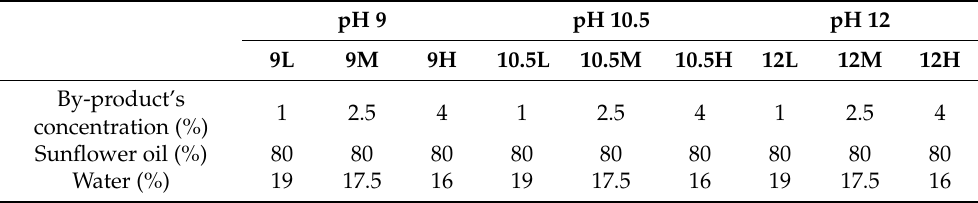
Table 3. Naming and composition of the samples according to the pH of the aqueous phase and the concentration of by-product in